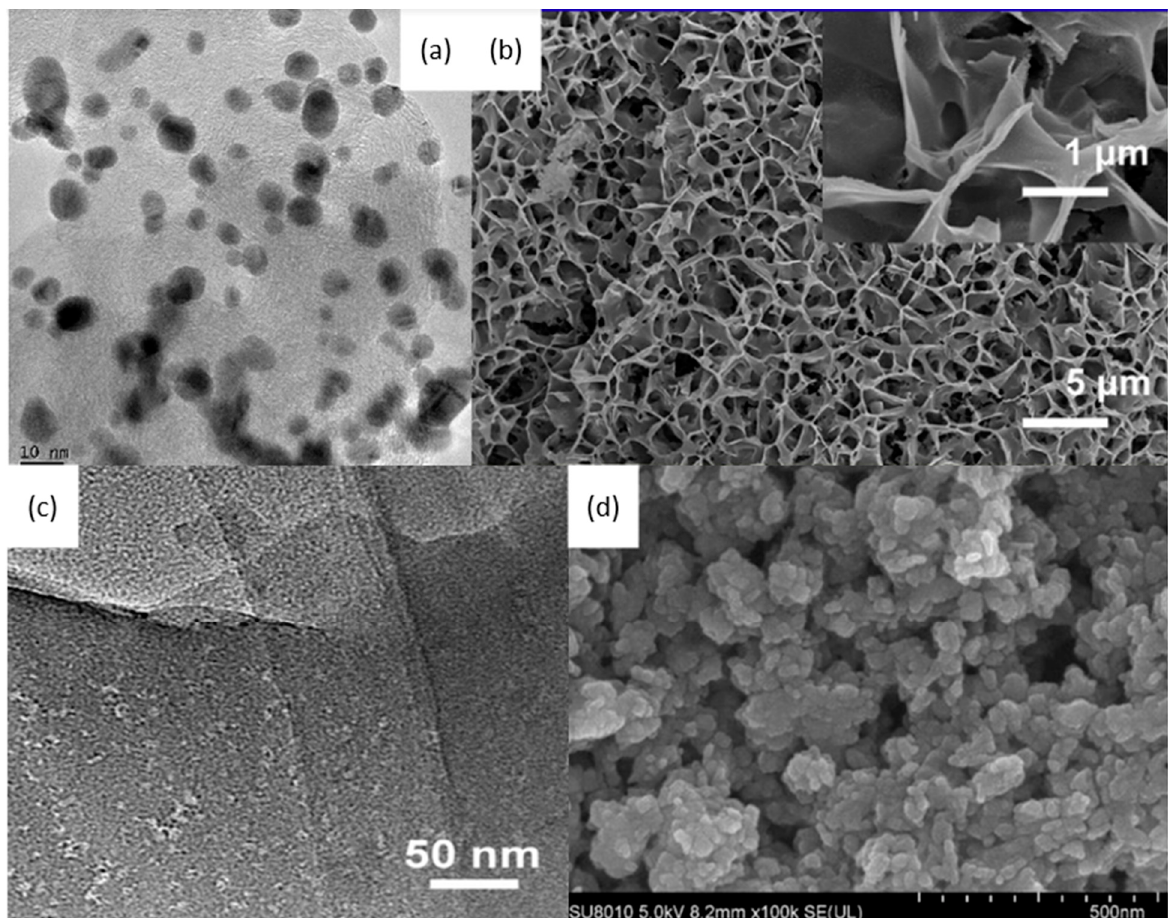
Figure 22. ( a ) TEM of Pd 3 Au 7 /C, reprinted with permission from Ref. [110]. Copyright 2019, Applied Catalysis B: Environ- mental. ( b ) SEM of Co-Ni alloy, reprinted with permission from Ref. [112]. Copyright 2020, Journal of Alloys and Compounds. ( c ) SEM of Co 0.5 Ni 0.5 (OH) 2, reprinted with permission from Ref. [113]. Copyright 2020, Journal of Electroanalytical Chemistry. ( d ) SEM of Ni-MoS 2, reprinted with permission from Ref. [114]. Copyright 2020, International Journal of Hydrogen Energy.